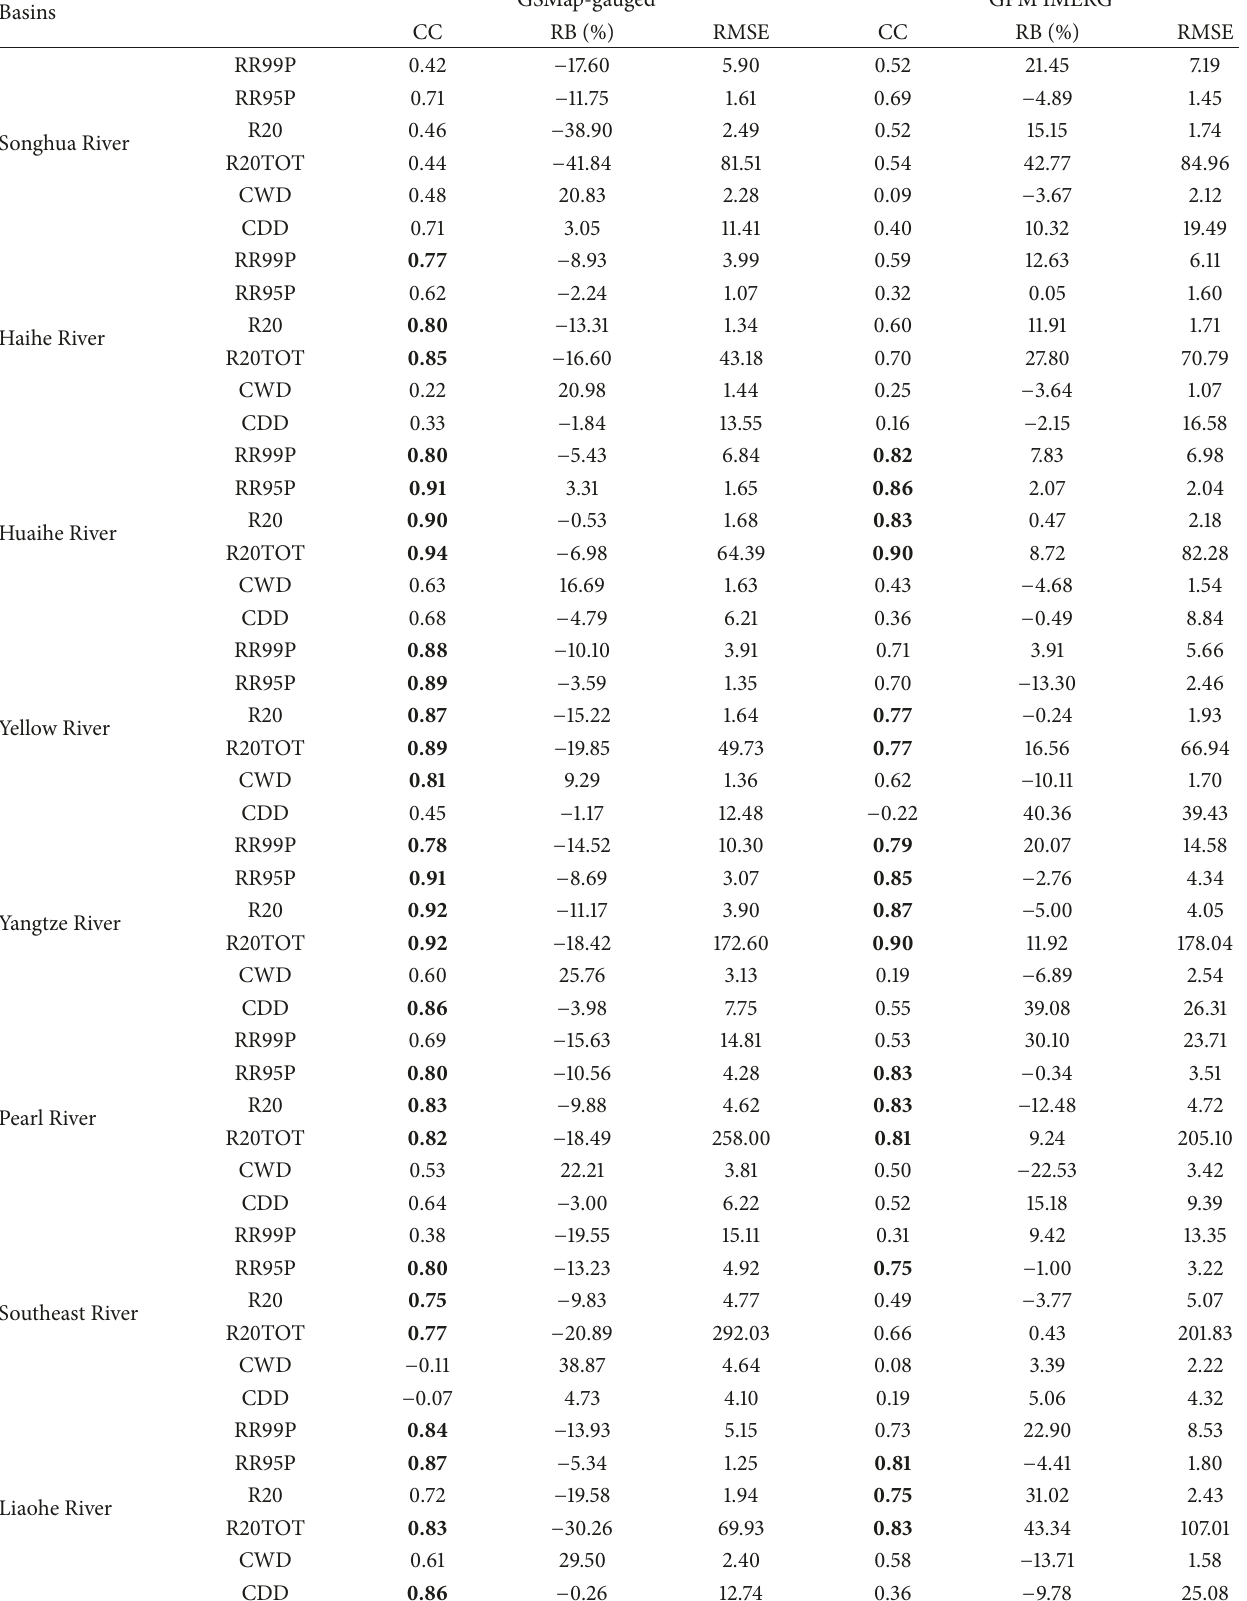
Table 6: Statistics of extreme precipitation indices for the eight river basins over eastern China.